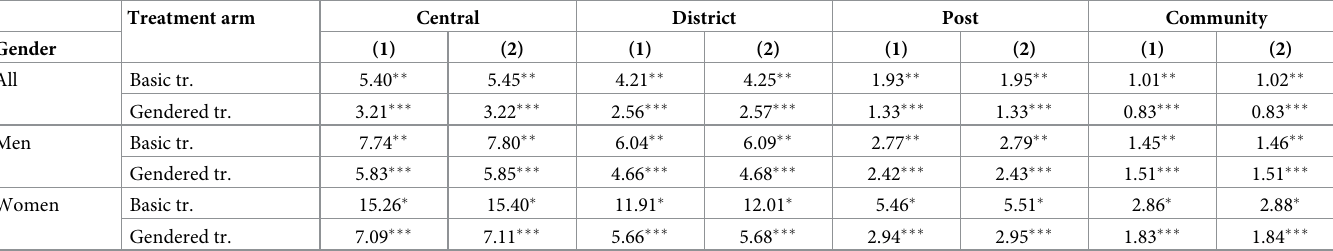
Table 8. CGAAS: Cost-effectiveness in increasing SLM farming methods awareness. Treatment